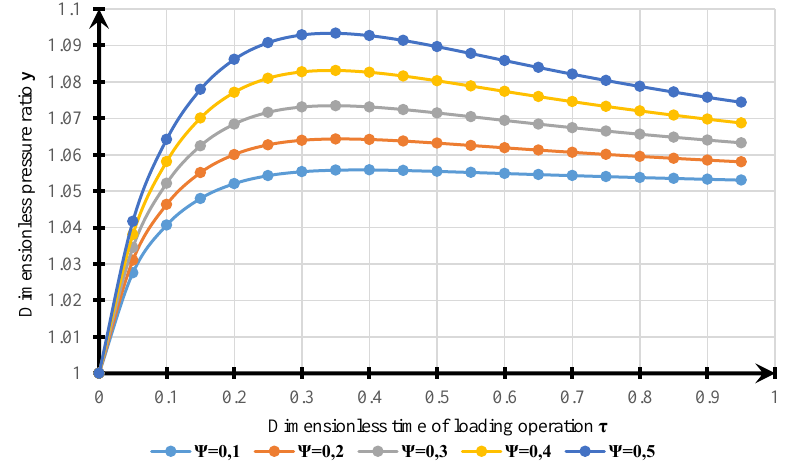
Figure 3. The graph of changes in the dimensionless pressure for various parameter Ψ , θ = 0.3; ε = 0.8.